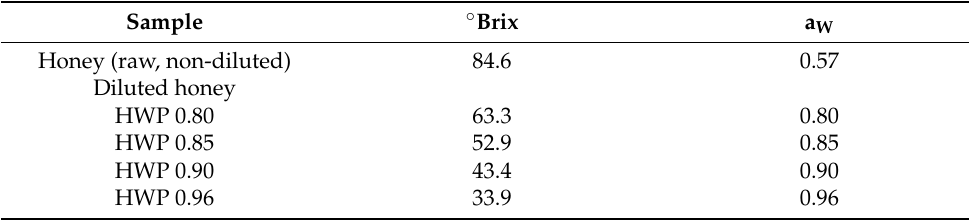
Table 1. Honey and honey–water preparations (HWP) with an adjusted water activity (a W ). Sample ◦ Brix Honey (raw,